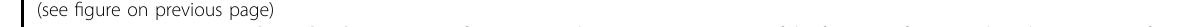
Fig. 5 LNC-SNO49AB regulates the dimerization of ADAR1. a Schematic representation of the function of ADAR1. The editing activity of ADAR1 requires homodimerization. b Immunoprecipitation of FLAG-ADAR1 with HA-ADAR1 was performed using 293T cells. Immunoprecipitation of FLAG- ADAR1 was performed using 293T cells. IgG, immunoglobulin G. Representative results are shown from three replicates. c Immunoprecipitation of the indicated FLAG-ADAR1 deletion mutants with HA-ADAR1 was performed using 293T cells. Representative results are shown from three replicates. d FLAG-ADAR1 and LNC-SNO49AB were coprecipitated with HA-ADAR1 in whole-cell lysates of 293T cells. e FLAG-ADAR1, HA-ADAR1 and LNC- SNO49AB were coprecipitated with an anti-FLAG antibody, and after elution with FLAG peptide, all were further coprecipitated with an anti-HA antibody in the resultant precipitates. Representative results are shown from three replicates. f Schematic of deletion mutants of LNC-SNO49AB. g Immunoblot detection of endogenous ADAR1 retrieved by in vitro-transcribed tRSA-tagged LNC-SNO49AB sections from MOLM13 cell lysates. All of the LNC-SNO49AB sections presented signi fi cant enrichment. Tubulin as the negative control. h , i LNC-SNO49AB promoted the binding between recombinant FLAG-ADAR1 and HA-ADAR1 in vivo ( h ) and in vitro ( i ). Representative results are shown from three replicates. j Schematic overview of the RNA-editing reporter assay. k Normalized luciferase in 293T cells transfected with LNC-SNO49AB and control. Values are the means ± SEM of three independent experiments. * P < 0.05 by Student ’ s t -test. Representative results are shown from three